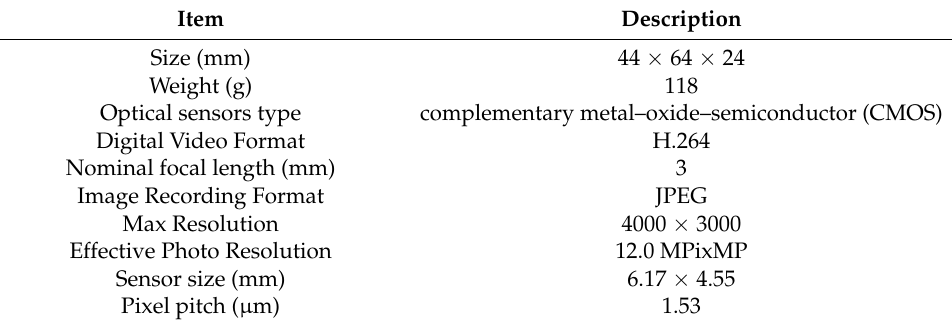
Table 1. Technical specification GoPro 5 Hero.